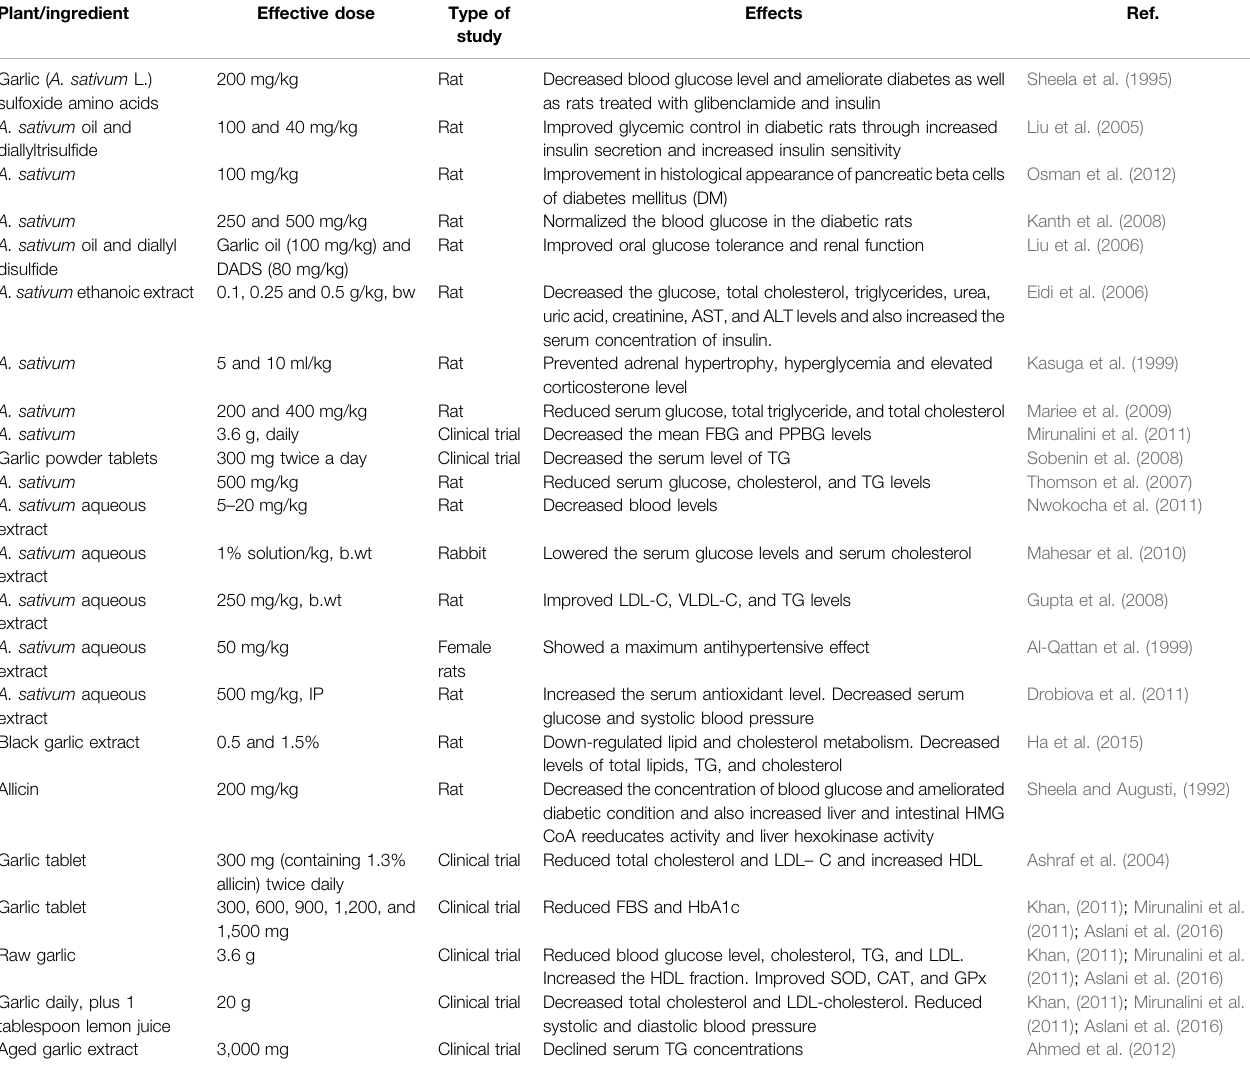
TABLE 3 | Effects of garlic and its ingredients on obesity, diabetes mellitus, and nonalcoholic fatty liver disease.